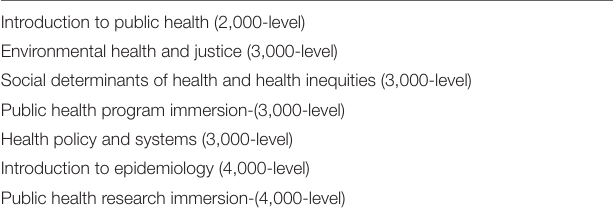
TABLE 1 | List of undergraduate public health courses by